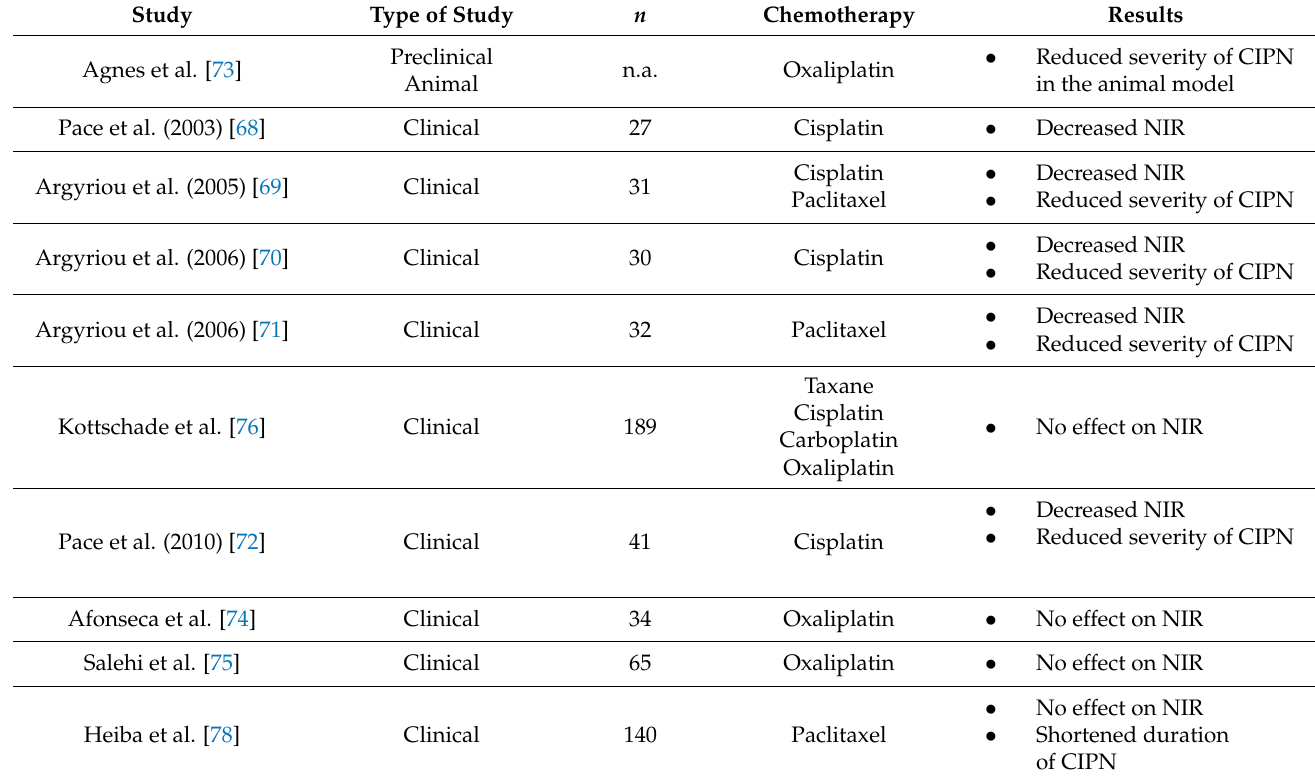
Table 3. Efficacy of vitamin E in